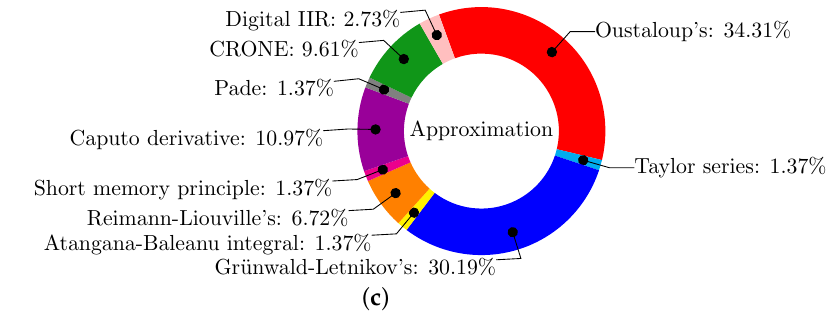
Figure 4. Summary of controller, optimization and approximation technique details from Table 1.